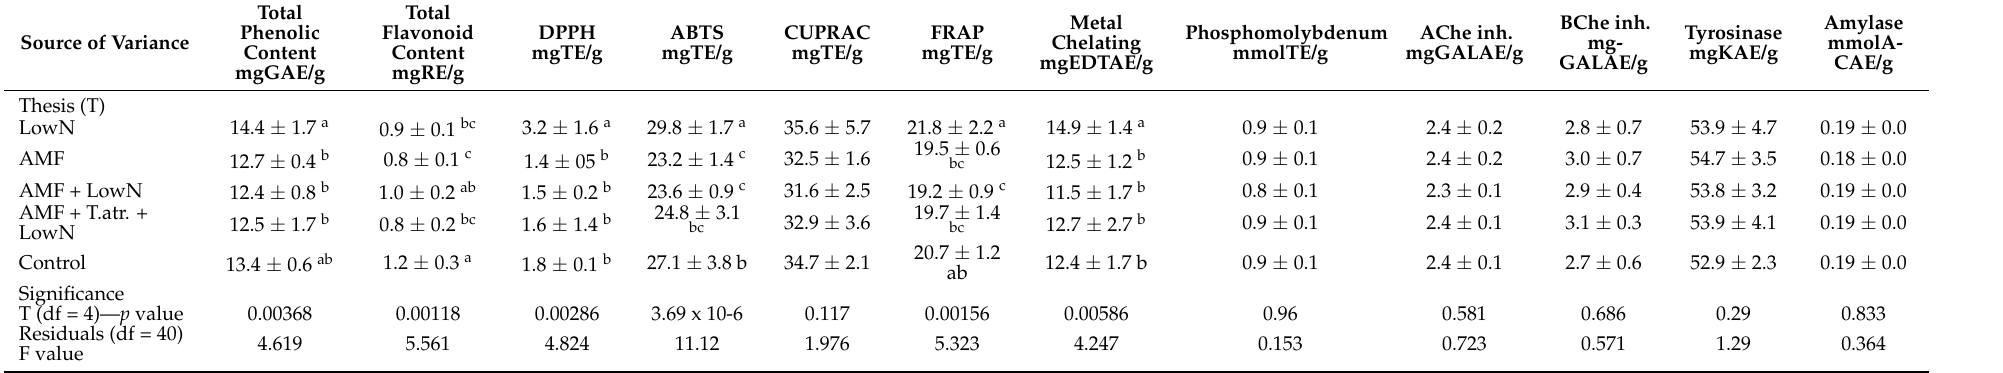
Different letters show significant difference at the 0.05 probability level. Table 6. Antioxidant assays and enzyme inhibition properties in tomato fruits from plants grown under low nitrogen fertilization regimen, treated with different biostimulants at the site with optimal soil fertility. The data were elaborated by one-way analysis and Duncan